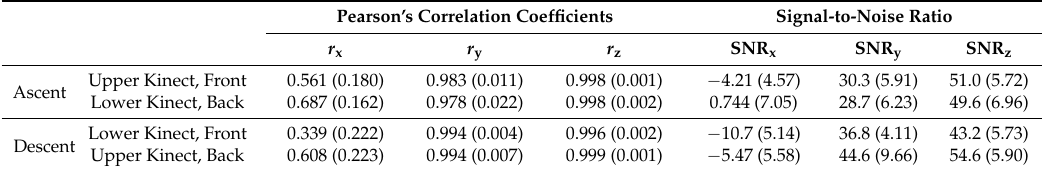
Table 2. Accuracy of knee joint positions estimated by our method relative to VICON values: Pearson’s correlation coefficients and signal-to-noise